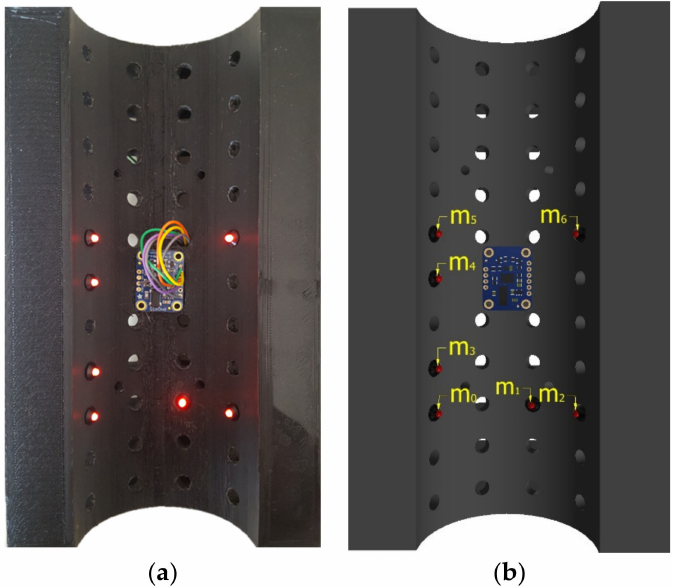
Figure 5. Comparison between CAD and actual brick; ( a ) Actual brick; ( b ) CAD